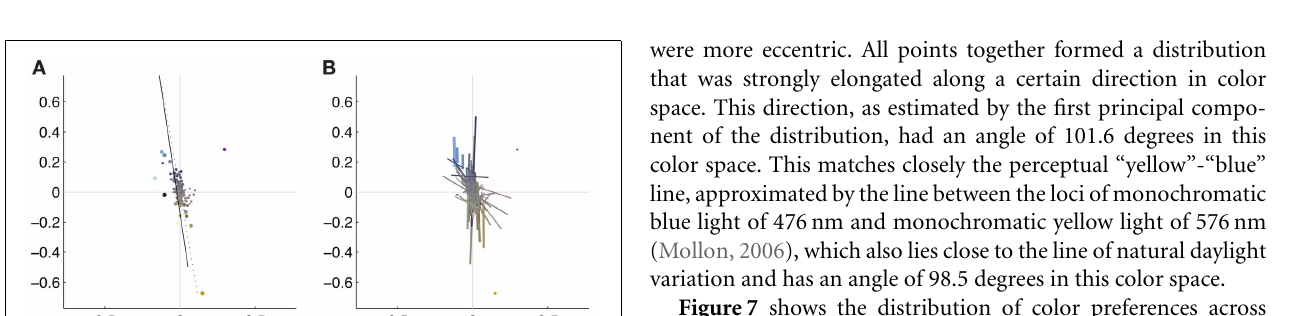
FIGURE 5 | Chromaticities of activation triggered averages: each pixel of every individual patch is projected onto an isoluminant plane in a cone-opponent color space. The horizontal axis is defined as L − M and the vertical axis as S − (L + M)/2. Luminance values correspond to brightness of pixels.